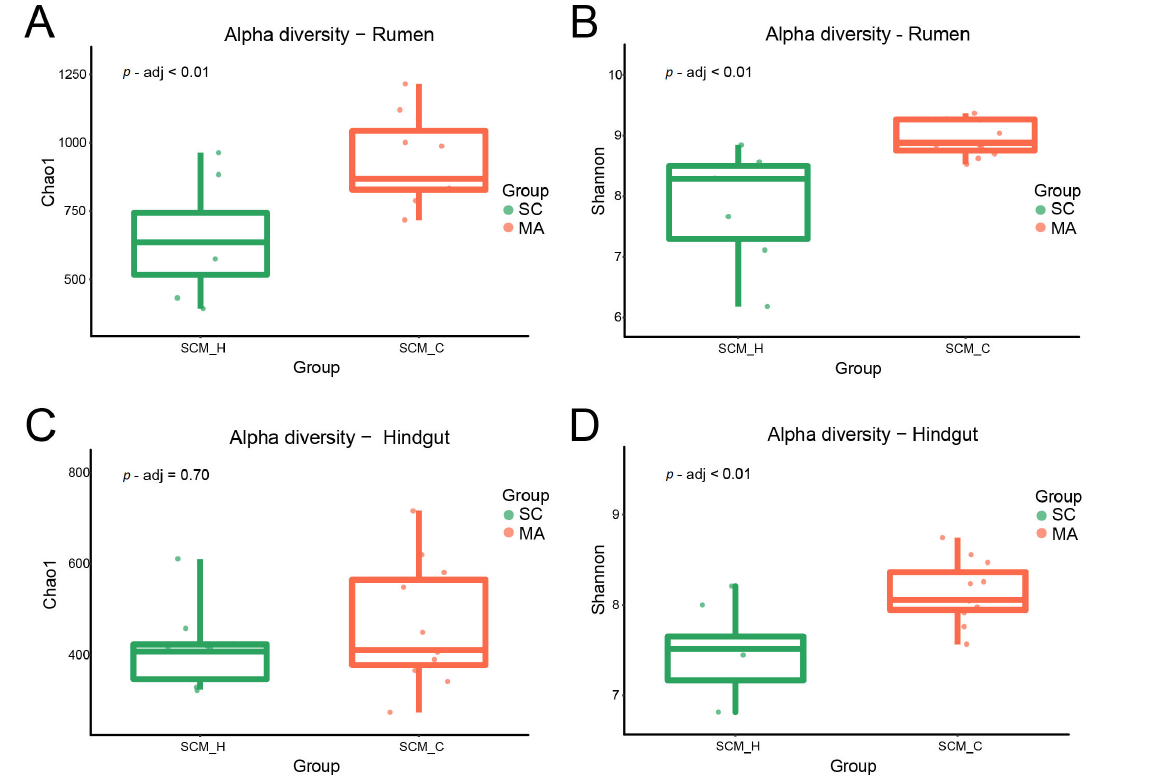
Figure 1. Alpha diversity of rumen and hindgut bacteria between high-somatic-cell-counts cows with healthy patterns (SC) and mastitis patterns (MA). ( A ) Chao 1 index and ( B ) Shannon index of rumen bacteria; ( C ) Chao 1 index, and ( D ) Shannon index of hindgut